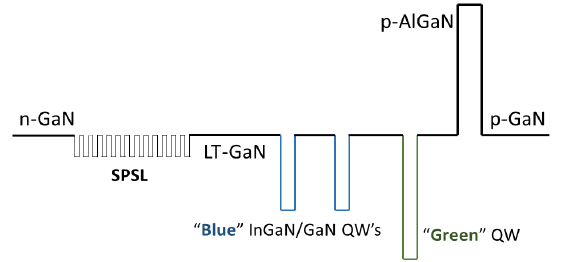
Figure 1. Conduction band schematic for the monolithic white LEDs depicting blue and green quantum wells (QWs) with bottom SPSL grown on top of n-GaN in order to facilitate carrier injection and improve growth.